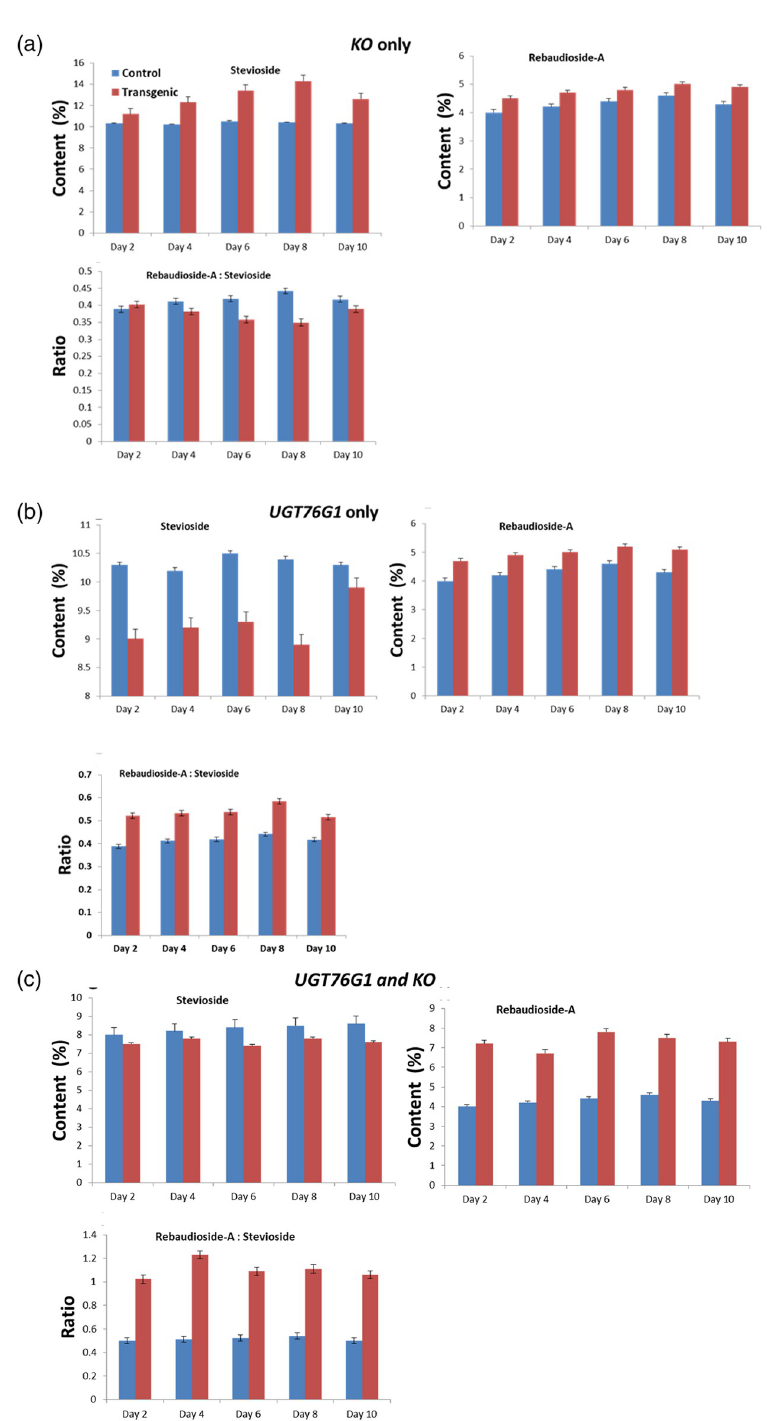
Fig 4. Concentration of stevioside and rebaudioside-A after overexpression of genes KO and UGT76G1 . A: only KO gene was overexpressed, B: only UGT76G1gene was overexpressed, C: UGT76G1 and KO genes were co- expressed.